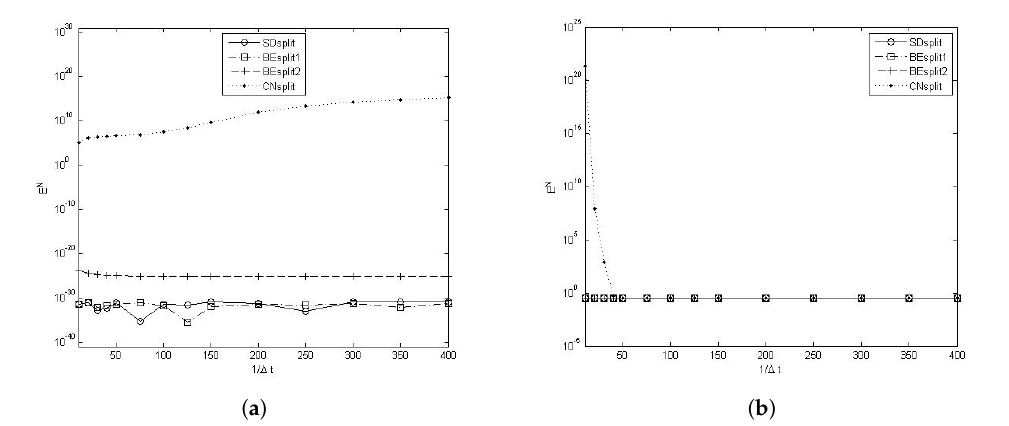
Figure 2. A comparison of E N computed using different choices of time step for different splitting methods with ( a ) O ( 1 ) k min and ’extremely small’ S 0 , i.e., k min = 1 and S 0 = 10 − 12 , and ( b ) with ’extremely small’ k min and O ( 1 ) S 0 , i.e., k min = 10 − 12 and S 0 = 1, [34].